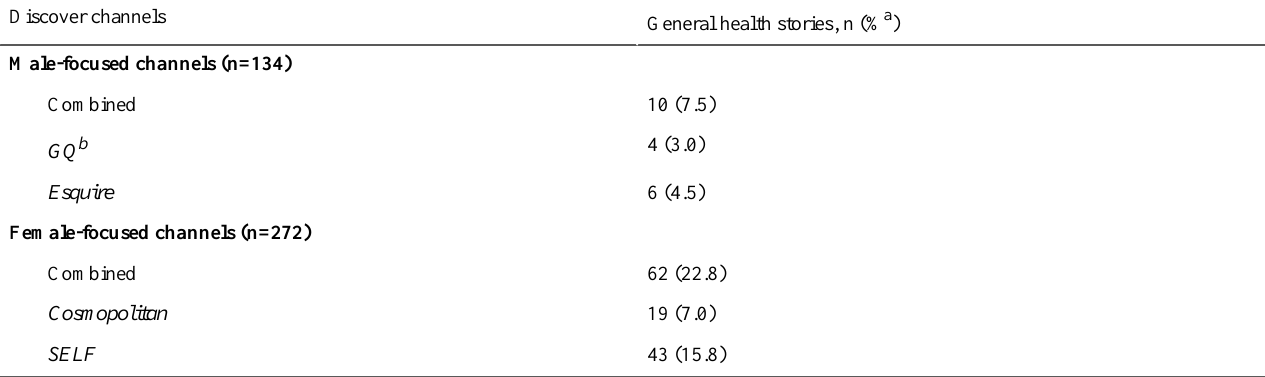
Table 1. Number and percentages of general health stories from male- and female-focused Discover channels.